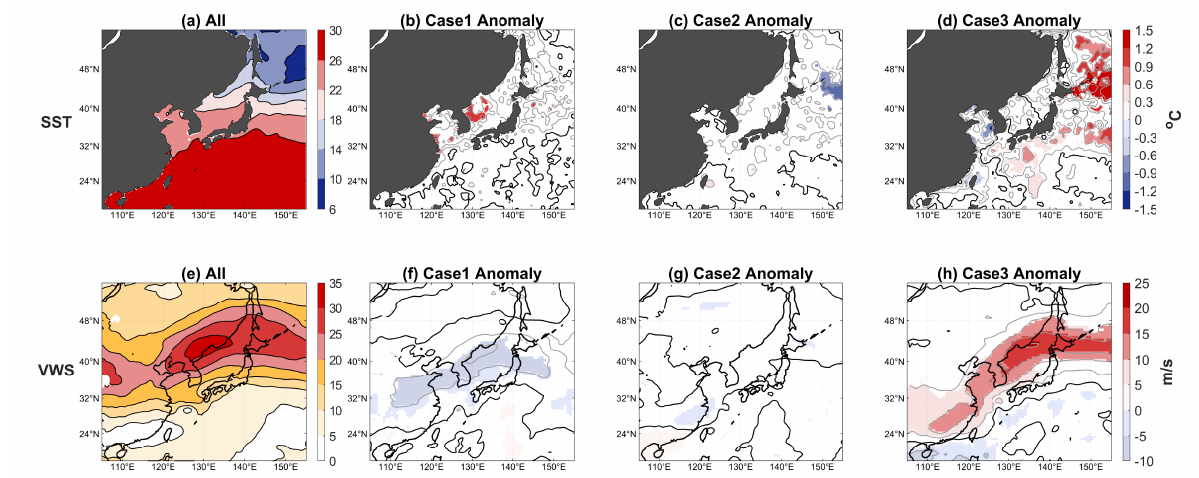
Figure 4. The composite maps of SST and vertical wind shear between 850 hPa and 200 hPa when TCs pass 30° N ( a , e ) and their anomalies for the three cases ( b – d , f – h ). In the anomaly maps, the statistically significant regions at the 95% confidence level are